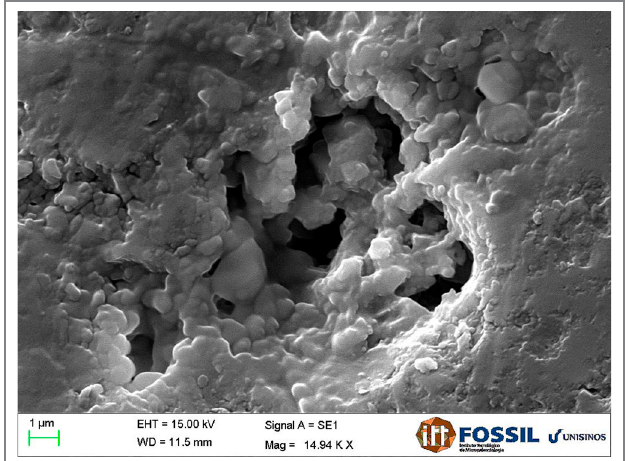
FIGURE 9 – WDS image of sample 2291 highlighting botryoidal structure.